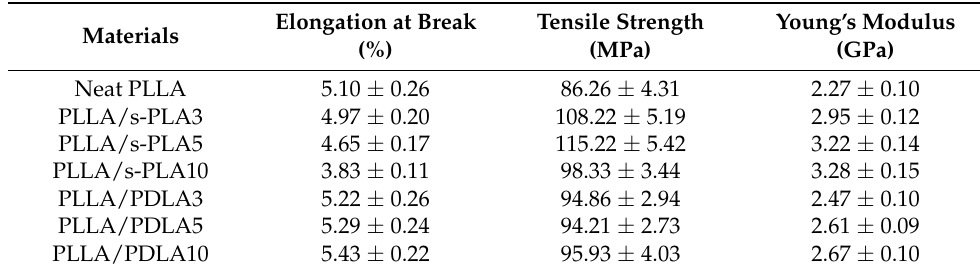
Table 1. The mechanical properties of PLLA homopolymers with addition of s-PLA and PDLA as the nucleating